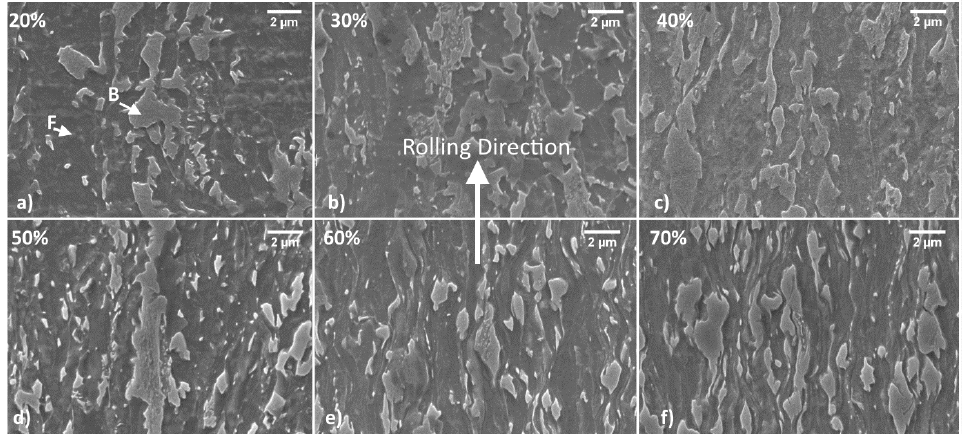
Figure 3. Microstructures of the DP steel as thinning level is increased, samples with transversal orientation observed with SEM. Thinning level is increased as follows 20, 30, 40, 50, 60, 70% represented in ( a ), ( b ), ( c ), ( d ), ( e ) and ( f ) panels.